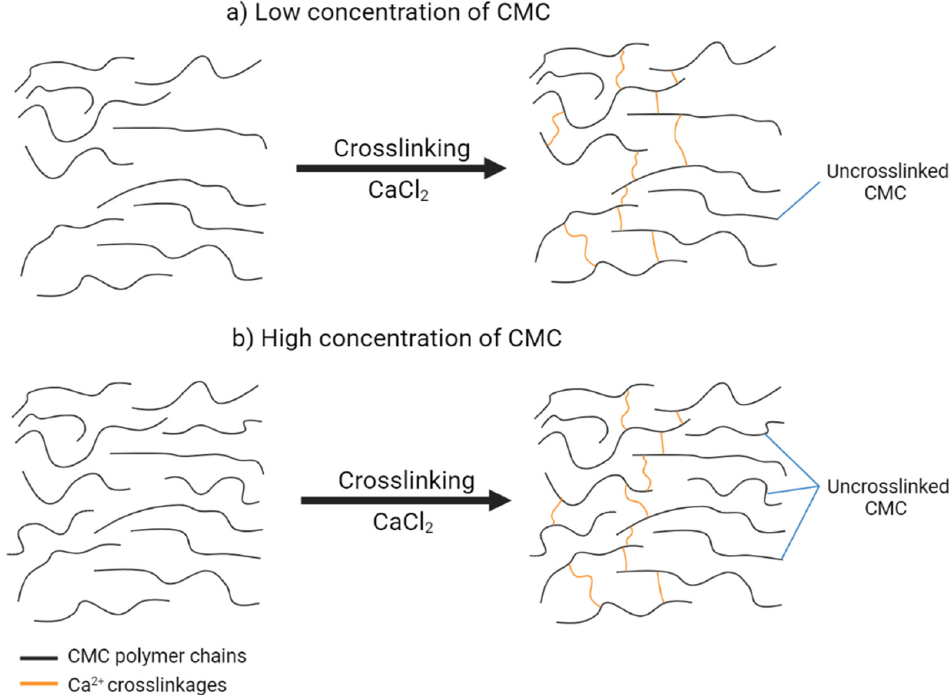
Figure 3. Schematic illustration of crosslinking reaction between CMC and CaCl 2 at ( a ) low concen- tration of CMC and ( b ) high concentration of CMC.